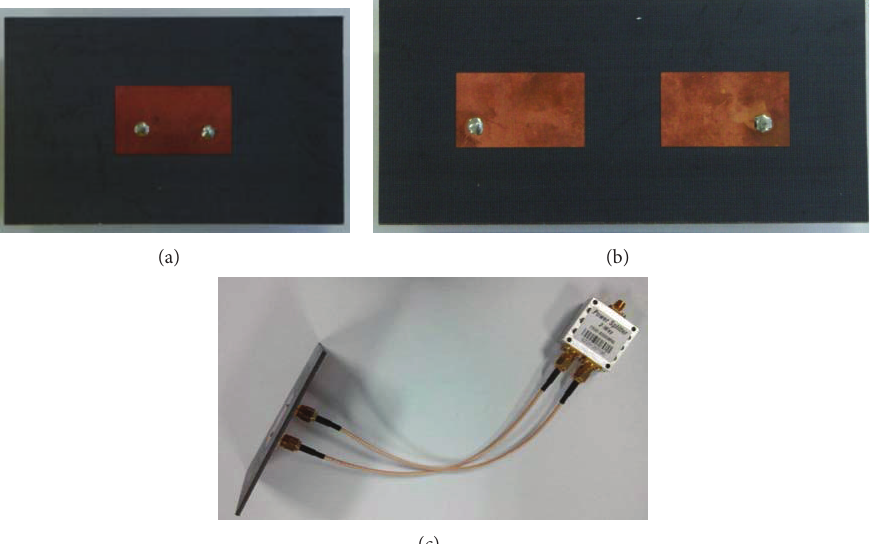
Figure 8: ((a), (b)) Photographs of the fabricated antennas and (c) photograph of the power divider used in the experiment.